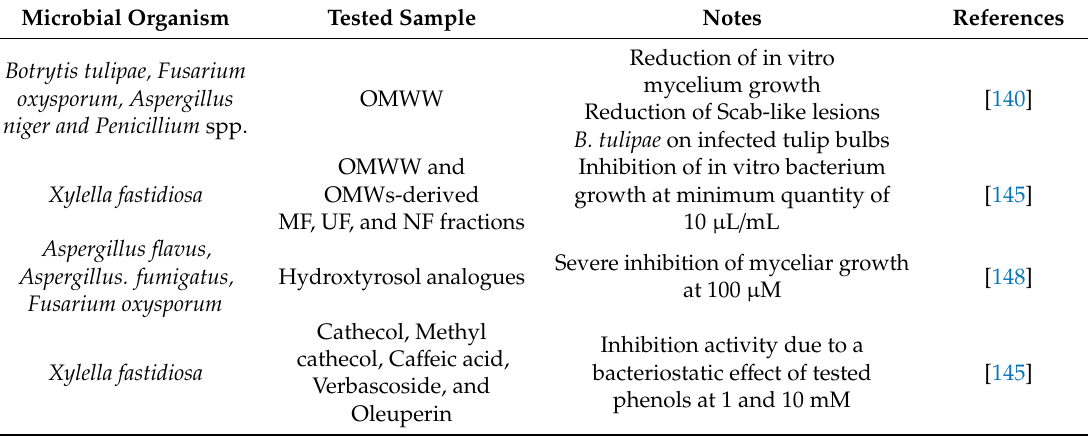
Table 3. Recent studies on the e ff ects of OMWs and derived molecules on microbial phytopathogens. Microbial Organism Tested